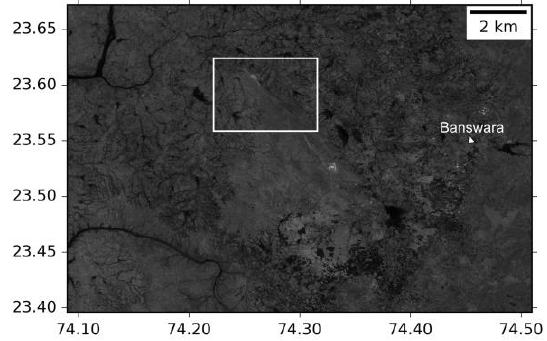
Figure 1. Location map of the study area overlaid on optical imagery of LISS-IV. The white coloured inset shows extent of AVIRIS-NG dataset chlorite schist, phyllites, marbles, gneisses and conglomerates. Post-Aravalli intrusive include granites, pegmatite, amphibolites and quartz veins. Banswara region is famous for its extensive cement grade Aravalli limestone